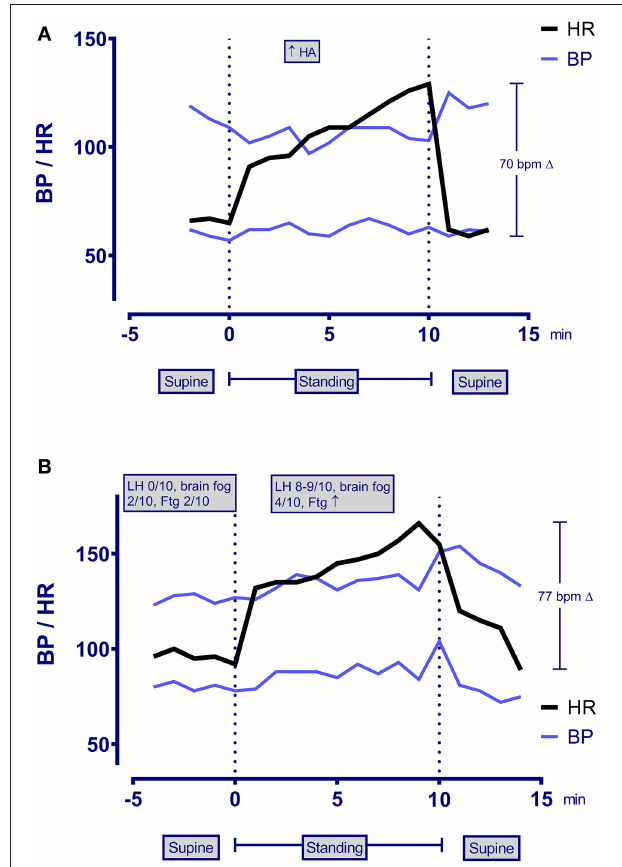
FIGURE 1 | Heart rate, blood pressure, and symptom changes during a 10-min passive standing test in patient 1 (A) and patient 2 (B) . LH, lightheadedness; Ftg, fatigue; bpm, beats per